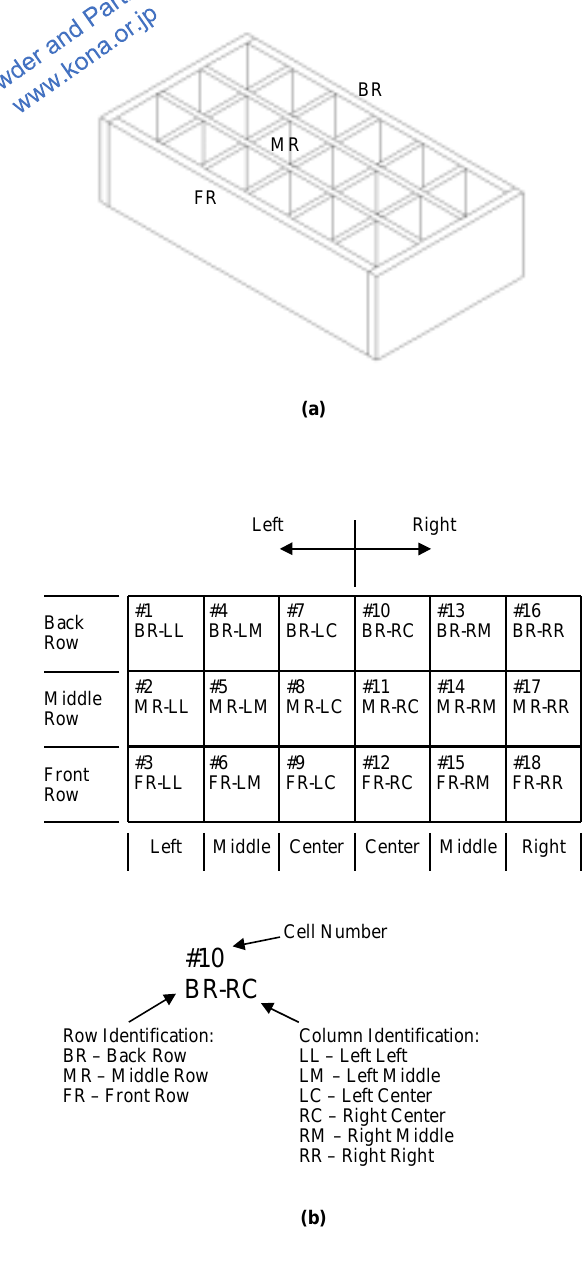
Fig. 2 Schematic of load cell collection assembly (a) isometric view, (b)